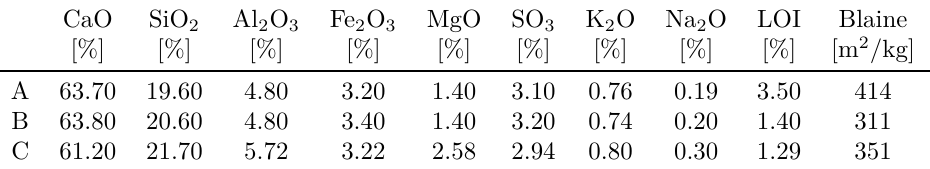
Table 1. Properties of studied cements.